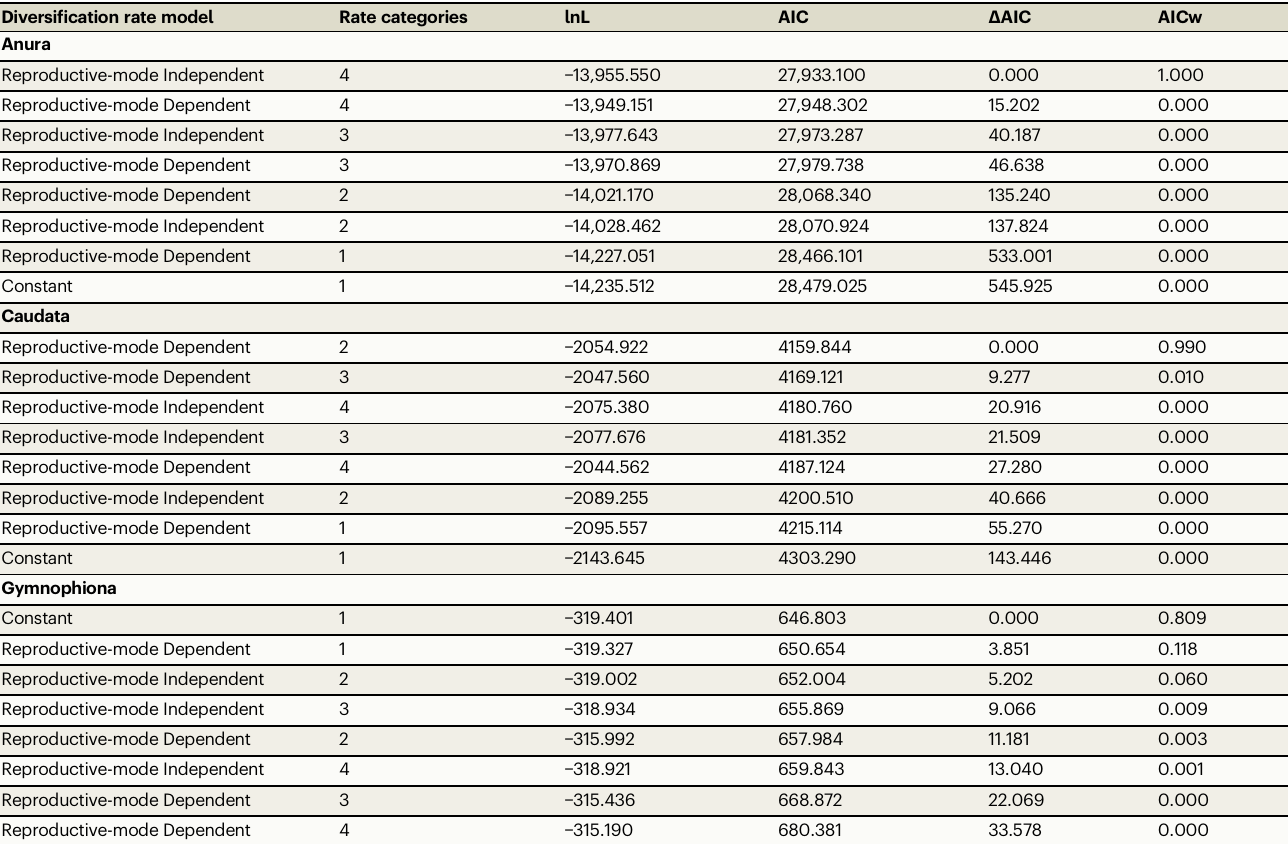
Table 1 | Ranking of model performance of state-dependent speciation and extinction “ hisse ” models for the three major groups of amphibians